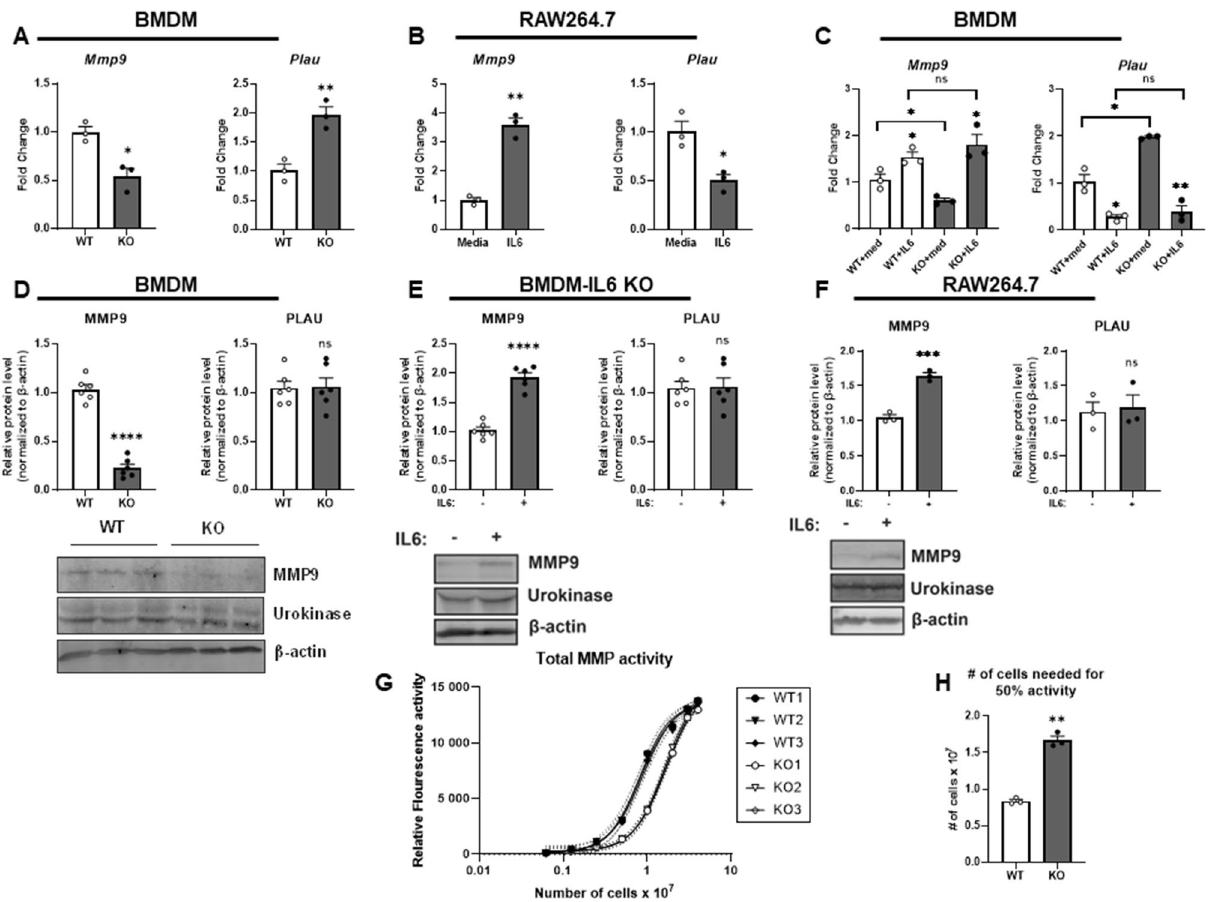
Figure 4. Endogenous IL6 promotes MMP9 expression and total MMP activity in BMDMs. ( A , B ) mRNA levels of the indicated factors were assayed in BMDMs derived from WT and I-L6 −/− mice and in RAW264.7 cells ( B ), respectively. ( C ) mRNA levels of Mmp9 and Plau were assayed in the indicated BMDMs after 24 h after stimulation with recombinant murine IL6 (20 ng/mL final concentration, 24 h). Data representative of 3 independent experiments and 6 biologic replicates. ( D ) Protein levels of MMP9 and urokinase were analyzed using immunoblotting in BMDMs derived from WT and IL-6 deficient mice with quantification of MMP9 and urokinase protein levels relative to total protein loading. ( E ) Protein levels of MMP9 and Urokinase were assayed in the BMDMs and ( F ) RAW264.7 cells after IL-6 stimulation. Gel blots cropped from different parts of the gel are presented, with white line separation. Quantification of protein levels relative to total protein loading is shown in the upper panels. All western blots performed with n = 6 biologic replicates. ( G ) Total MMP activity was assayed in the indicated BMDMs and represented as measured MMP activity per concentration of cell lysate to produce the dose–response curves which are shown. Data shown is representative of n = 3 biologic replicates per group, performed with 3 technical replicates per cell lysate concentration. ( H ) Averaged calculated cell concentration required to achieve half maximal MMP activity per the interpolated dose response curves for the indicated BMDMs is shown. All data presented as mean ± standard error of the mean. Normally distributed data was compared utilizing unpaired student’s test with Welch’s correction. n.s. not significant, *p < 0.05, **p < 0.01, ***p < 0.001, ****p <